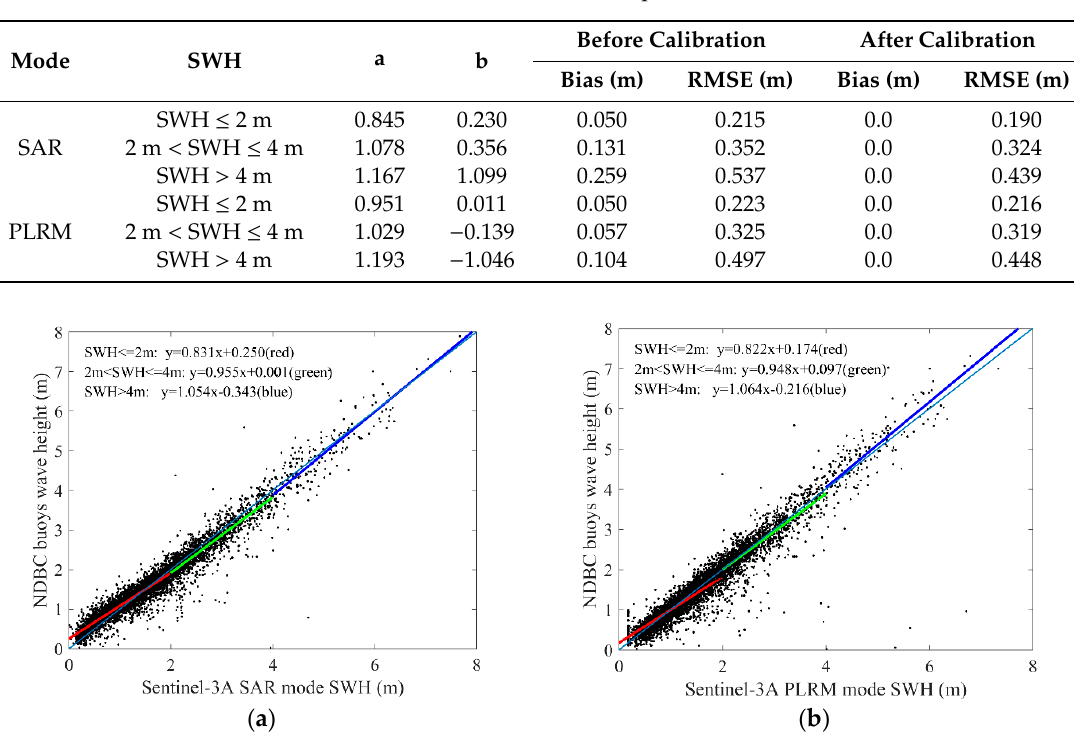
Table 3. coefficients of calibration functions and statistical parameters of Sentinel-3B SWH data.